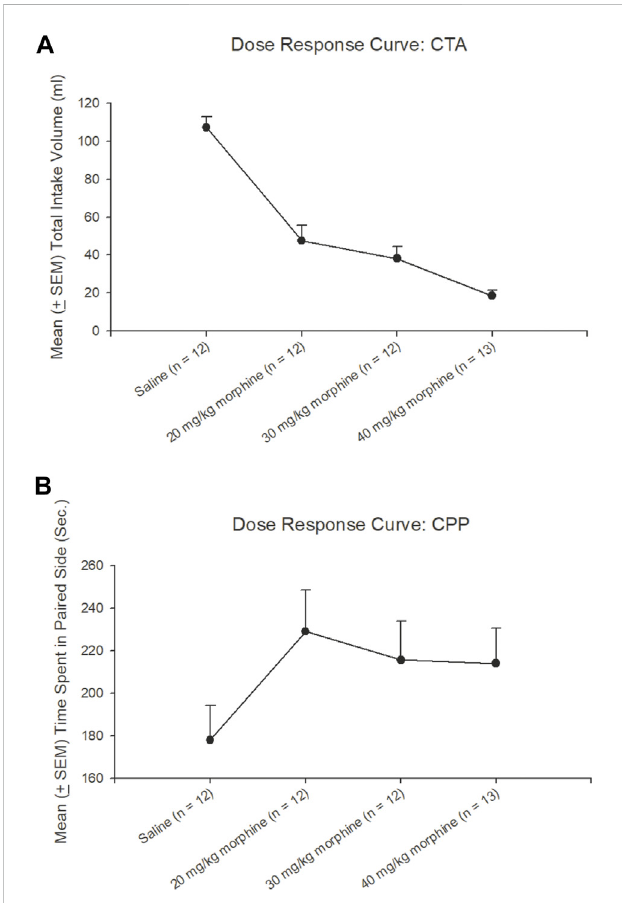
FIGURE 5 Dose-response curve tests under different doses of morphine injections or saline ( n = 12), 20 mg/kg ( n = 12), 30 mg/kg ( n = 12), and 40 mg/kg ( n = 13) in (A) conditioned taste aversion (CTA) and (B) conditioned place preference (CPP) during test phases,